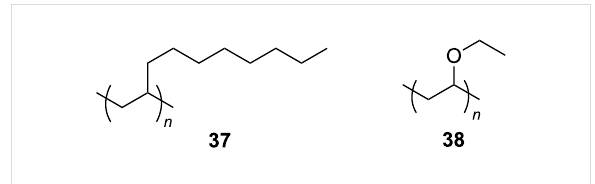
Figure 5: Structures of poly(1-decene) (37, P-1-D) and. poly(vinyl ethyl ether) (38, PVEE).